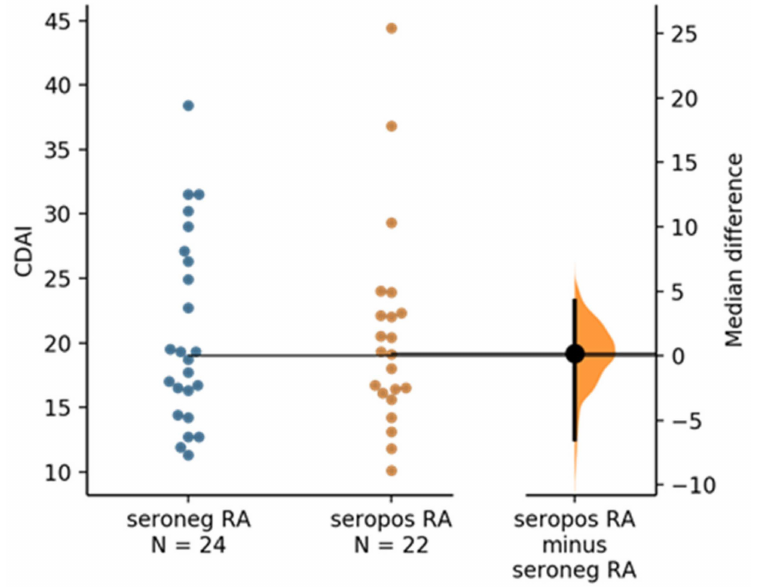
Figure 6. The median difference between seronegative RA and seropositive RA is shown in the above Gardner–Altman estimation plot. Both groups are plotted on the left axes; the mean dif- ference is plotted on a floating axis on the right as a bootstrap sampling distribution. The mean difference is depicted as a dot; the 95% confidence interval is indicated by the ends of the verti- cal error bar. The unpaired median difference between seronegative RA and seropositive RA is 0.2 [95.0%CI − 6.45, 4.25]. The p value of the two-sided permutation t -test is 0.9 (calculation and plot generated by https://www.estimationstats.com (accessed on 30 December 2021) according